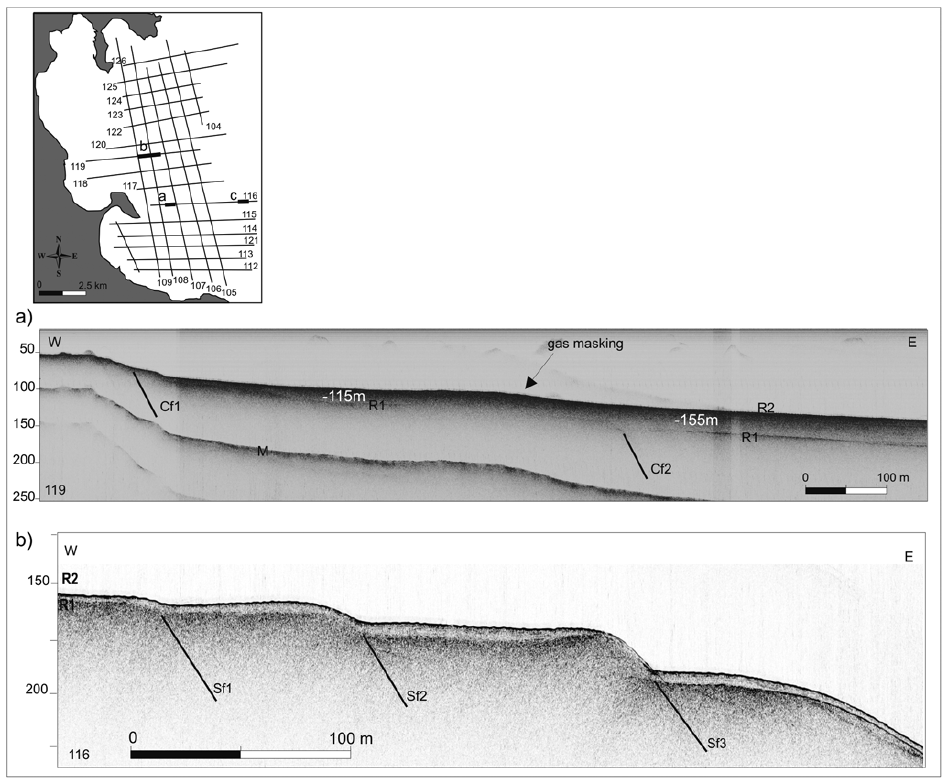
Figure 11. Location of the sections is shown in the profile grid (thick lines); a) R1 reflector displaced by fault Cf2 masked by the gas; numbers refer to depth of R1 surface on the footwall and hangingwall of the fault, M is the multiple; b) flight of scarps created by normal faults in the south- ern sector involving the R1 reflector below which there is evidence of the clinoform facies